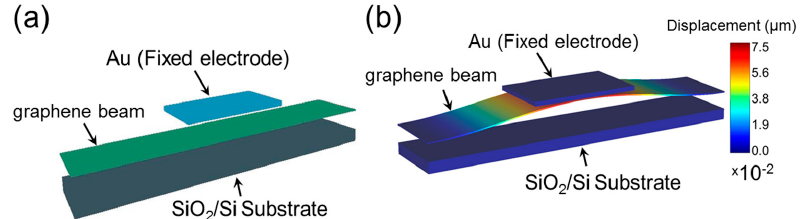
Figure 2. The geometry of NEM switch A. ( a ) Initial structure of double-clamped graphene beam NEM switch with a top metal electrode; ( b ) Pull-in state of the graphene beam; color bar indicates the relative displacement with respect to the initial condition.